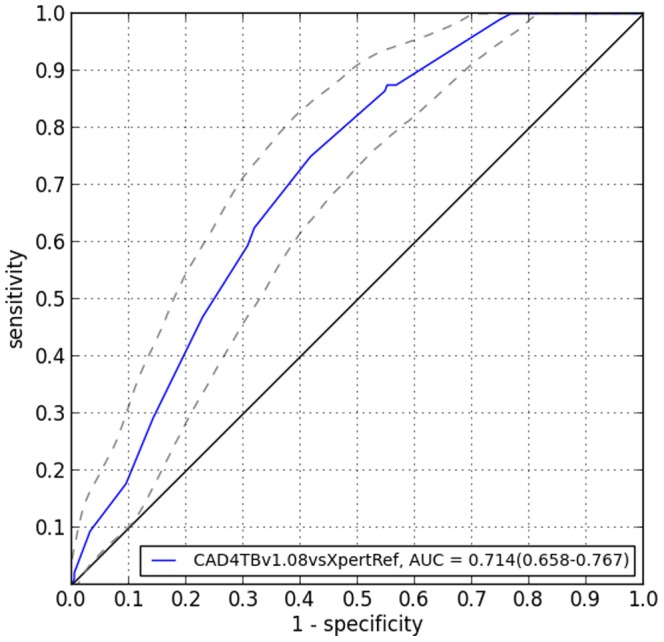
ROC curve comparing CAD score to Xpert TB as the reference standard.